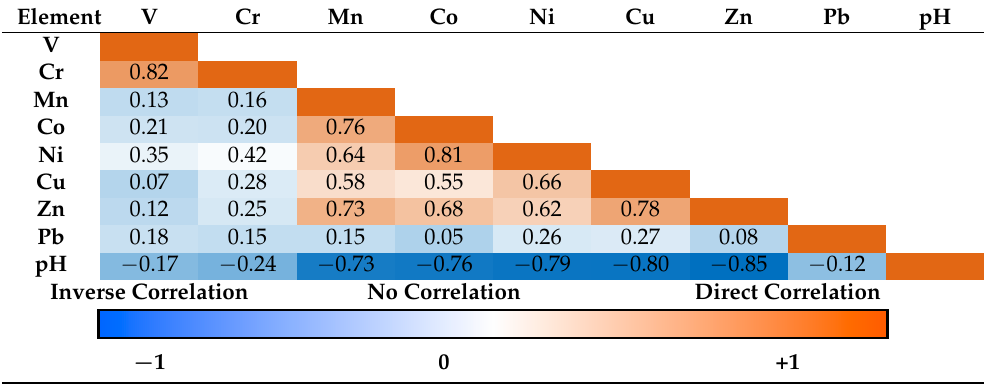
Table 2. Correlation among water-extractable fractions for different elements and pHs. Pearson’s linear correlation coefficient matrix ( p < 0.05) was calculated for the percent of water-extractable elemental components with respect to microwave-assisted aqua regia digestible total concentration for averaged quadruplicate IKMHSS tailings samples from all treatments, depths, and years ( n = 64). Element V Cr